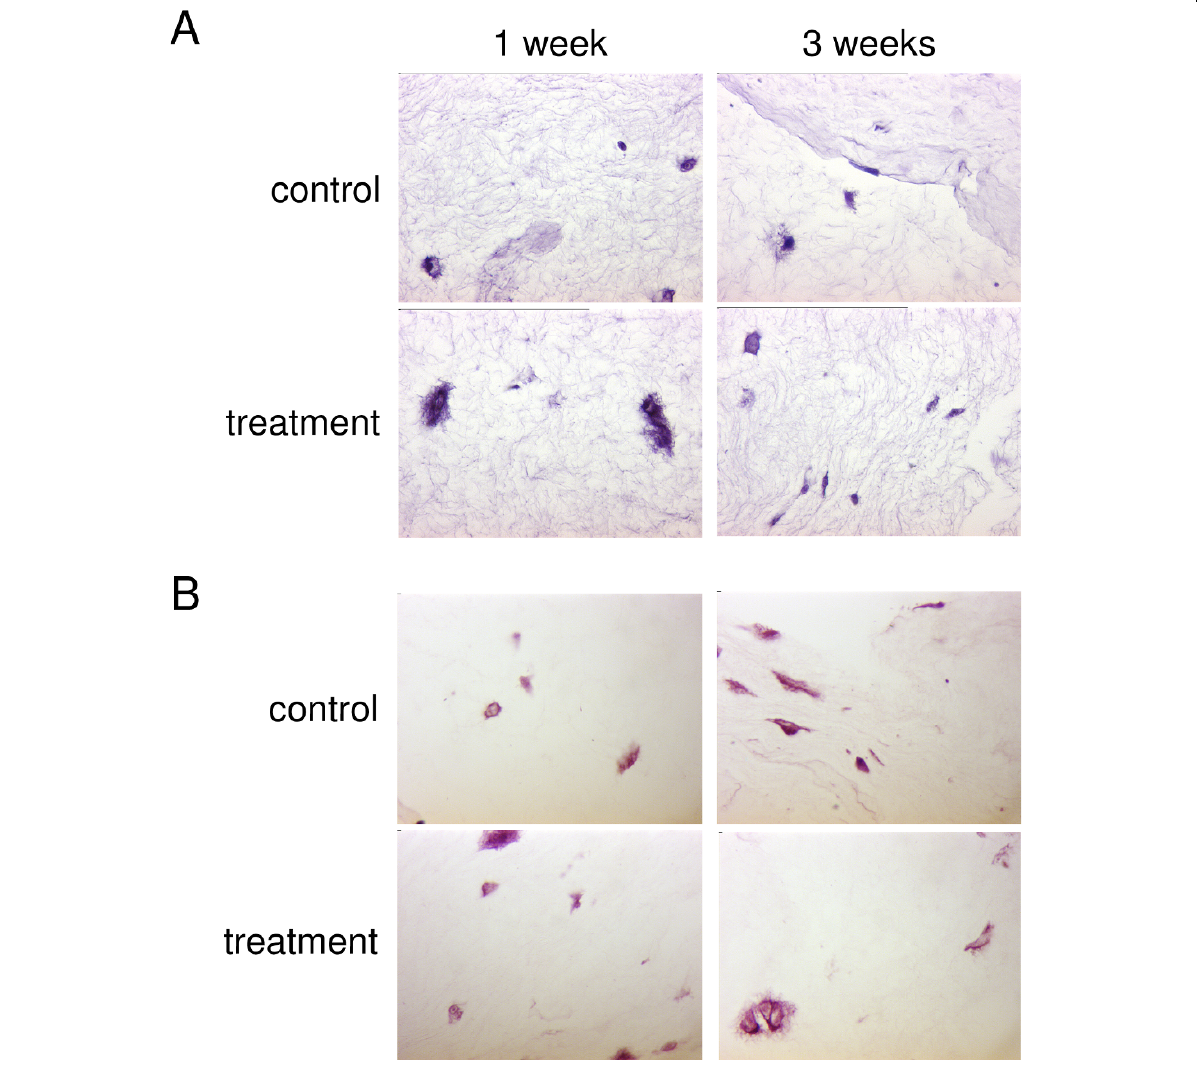
Figure 2 H&E and safranin O staining of in-vitro cultivated specimens . Hematoxylin-eosin staining (A) and safranin O staining (B) of collagen type-I gel seeded with human chondrocytes and cultivated for 1 and 3 weeks in-vitro. Samples were either left untreated (control) or stimulated by millicurrent treatment. Original magnification